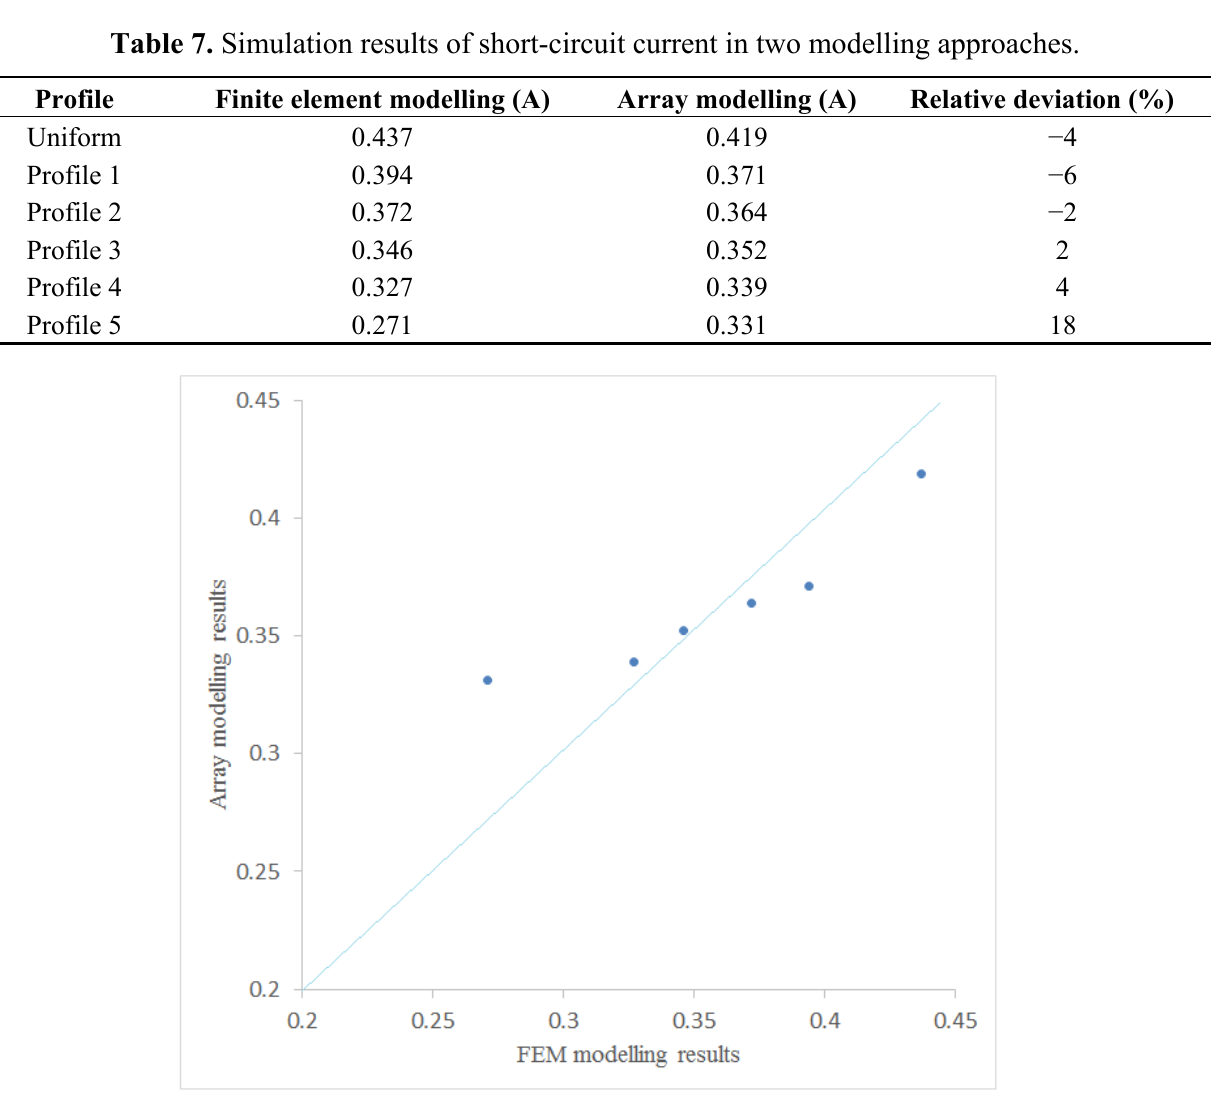
Figure 12. Simulation results from two modelling